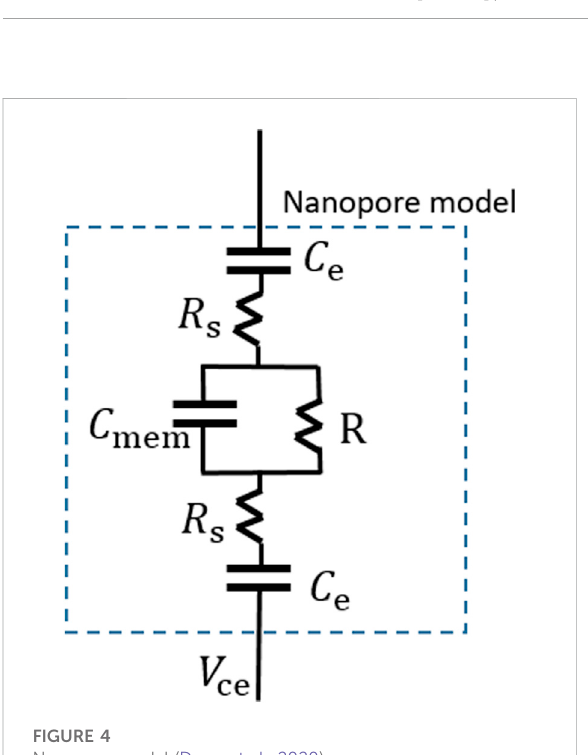
FIGURE 4 Nanopore model (Dong et al.,